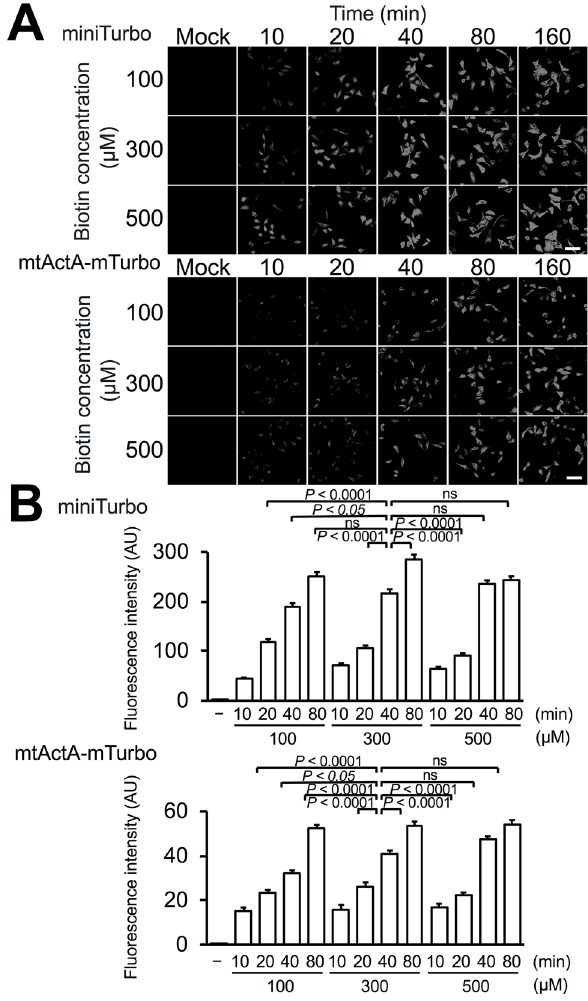
Figure 1. Fluorophore-conjugated streptavidin reacted with biotinylated proteins in cells after fixation with glutaraldehyde-containing mixture. ( A ) HeLa cells expressing miniTurbo ( A , upper panel) and mtActA-mTurbo fusion protein ( A , lower panel) were incubated in the presence of biotin (100, 300, and 500 μM) for the indicated times (10–160 min). After permeabilization, DyLight 549-streptavidin was reacted with the biotinylated proteins. Fluorescent images were obtained using a BZ-X810 fluorescence microscope (CCD monochrome camera, Nikon CFI Plan Apochromat × 40 lens, gain + 16 dB) using a filter set (excitation: 520–570 nm, dichroic mirror: 565 nm long pass, emission: 535–675 nm). ( B ) Fluorescent intensity in ( A ) was evaluated by ImageJ software. Error bars indicate the standard errors. Scale bar, 200 µm. * P value < 0.05, **** P value < 0.0001, ns not